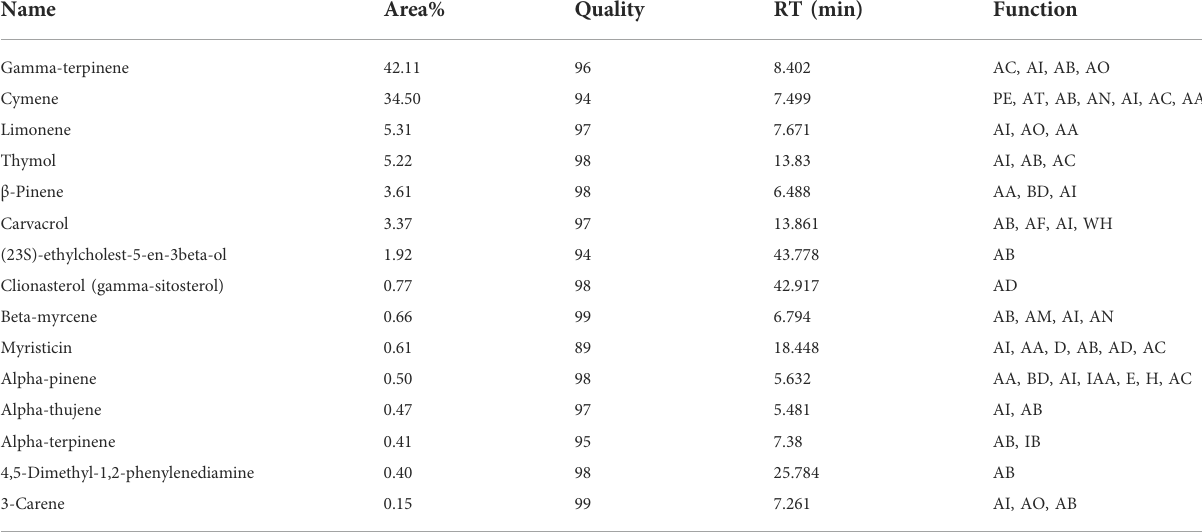
TABLE 2 Chemical composition of the Oliveria decumbens Vent. fl ower as shown from high to low in respect to their presence percentage in the sample. AC (anti-cancer), AI (anti-in fl ammatory), AB (antibacterial), PE (phlegm eliminator), AT (antitussive), AO (antioxidant), AA (anti-anxiety), BD (bronchodilator), AF (Antifungal), WH (wound healing), AD (antidiabetic), AM (antimutagenic), AN (analgesic), D (digestion), IB (immune system booster), AO